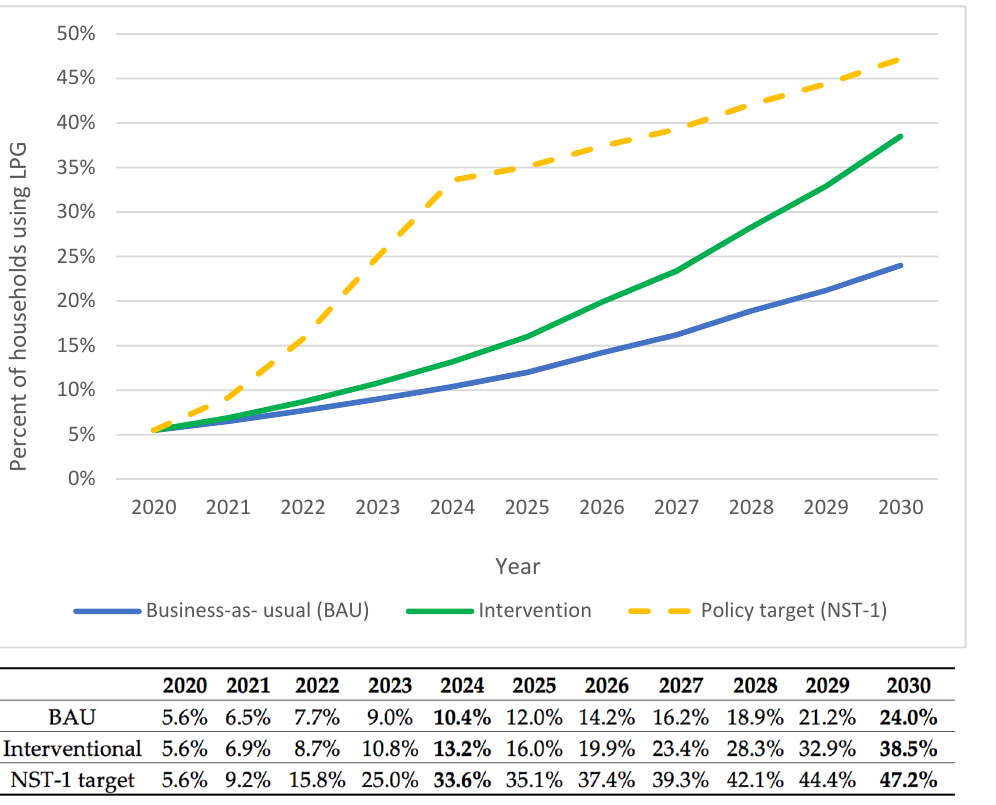
Figure 1. Adoption scenarios based on proportion of households using liquefied petroleum gas (LPG) for cooking.